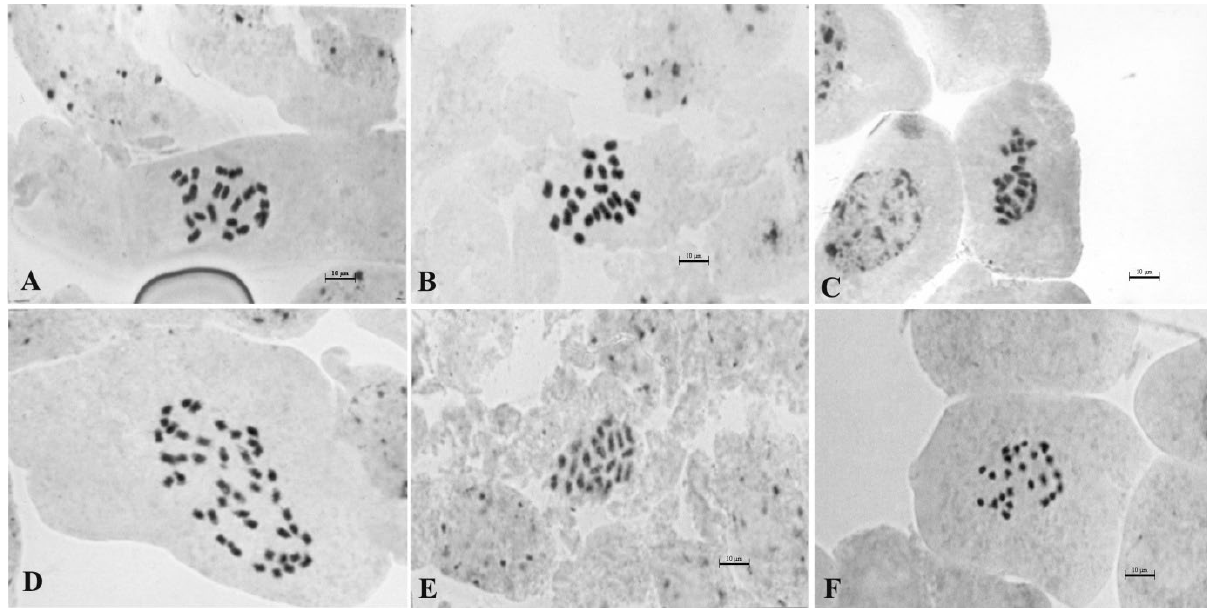
Figure 2. Photomicrographs of somatic metaphase chromosomes in root tip cells: Periploca angustifolia (A), Caudanthera sinaica (B), dip- loid Caudanthera edulis (C), tetraploid Caudanthera edulis (D), Desmidorchis acutangulus (E), Leptadenia arborea (F). Scale bar = 10